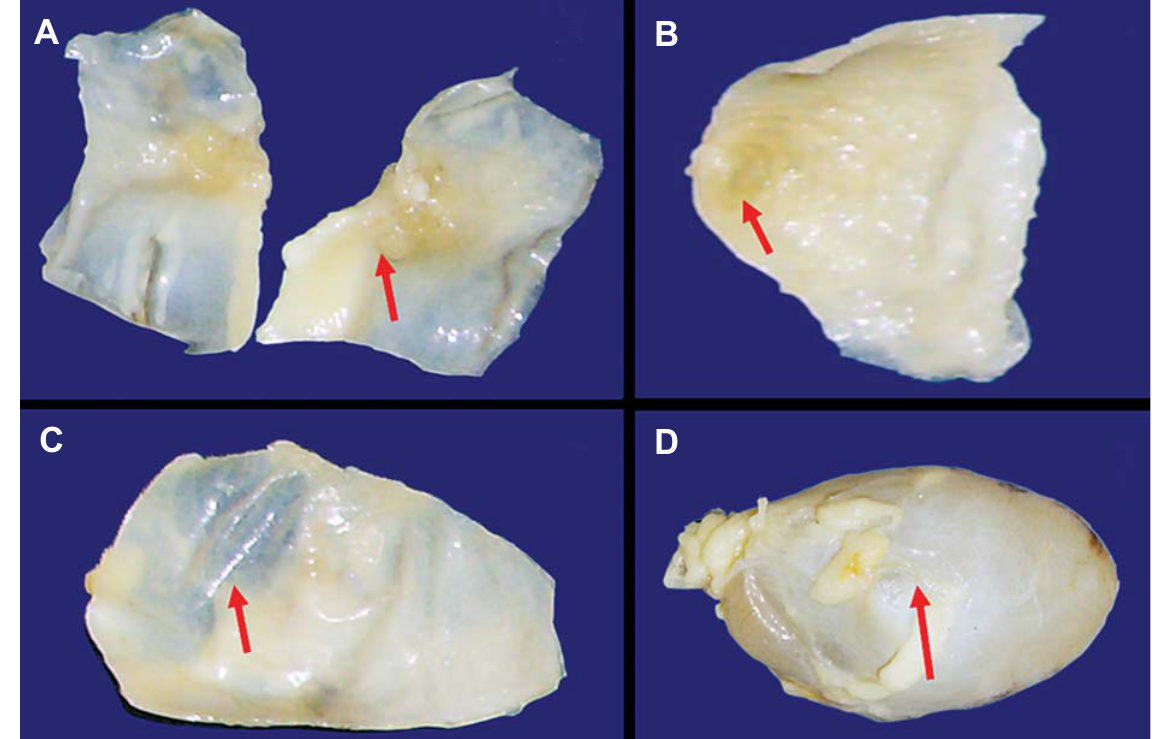
Figure 1 – Macroscopic evaluation of the latex biomembrane. A) Presence of the membrane 15 days after surgery. B) Thick bladder wall at 45 days. C) and D) Incorporation of the latex membrane (interior) and spherical architecture (exterior) after 3